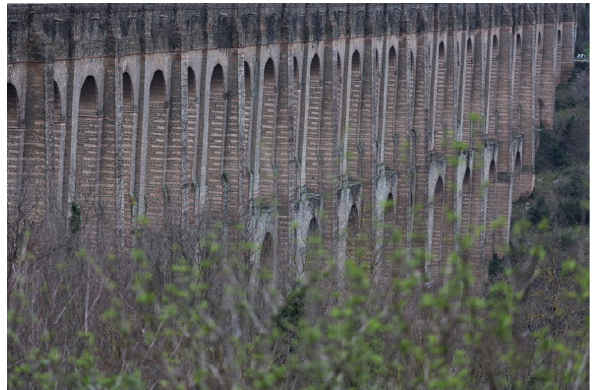
Figure 4 . ‘Carolino’ Aqueduct. ‘Ponti della Valle’ (Credit: